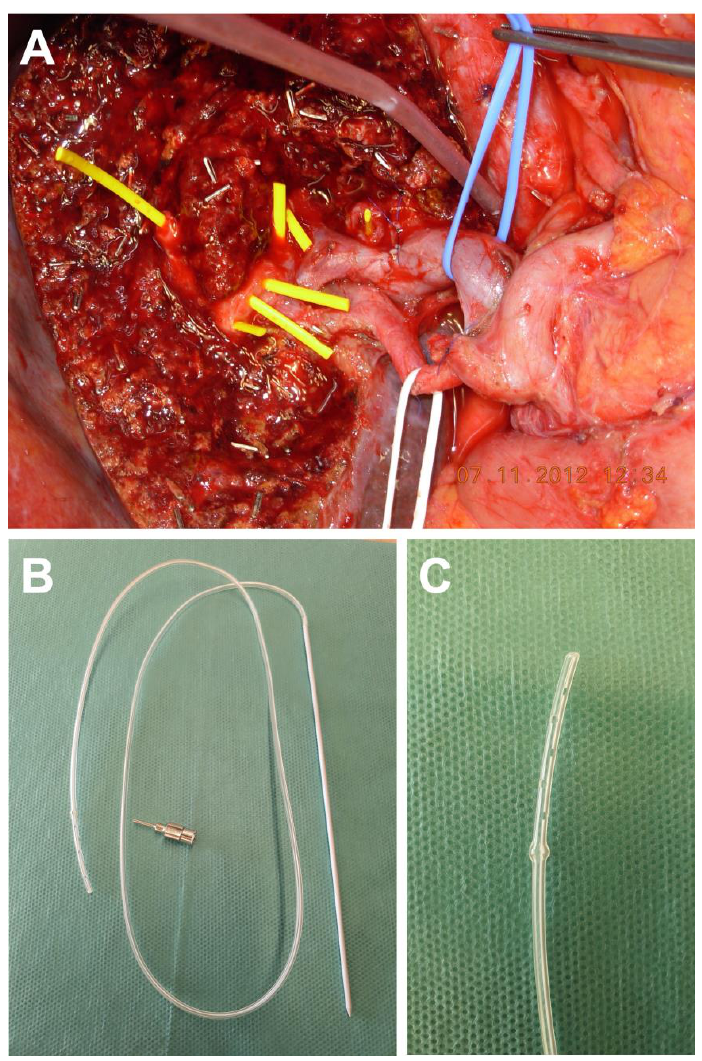
Figure 1. Intraoperative view after extended left hepatectomy for perihilar cholangiocarcinoma.